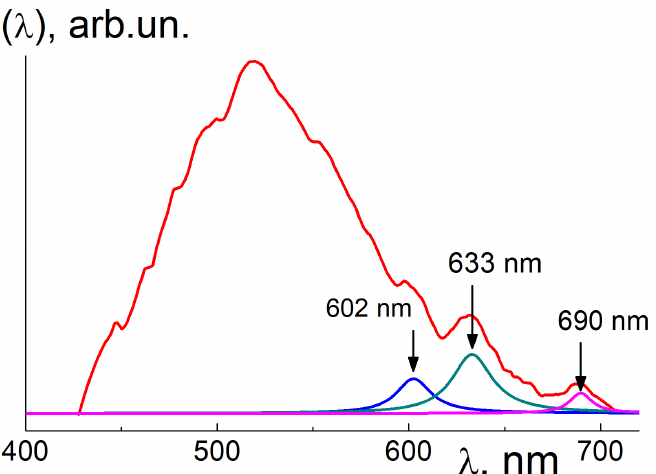
Figure 12. XEOL spectrum for the SEu3 sample (red curve) showing Eu 3+ characteristic bands corresponding to the electron transitions 5 D0 → 7 F 1,2,4 (maxima at 602; 633; 690 nm). Lorentzian fitting (blue, green, violet curves) for the bands is shown with maxima indications.